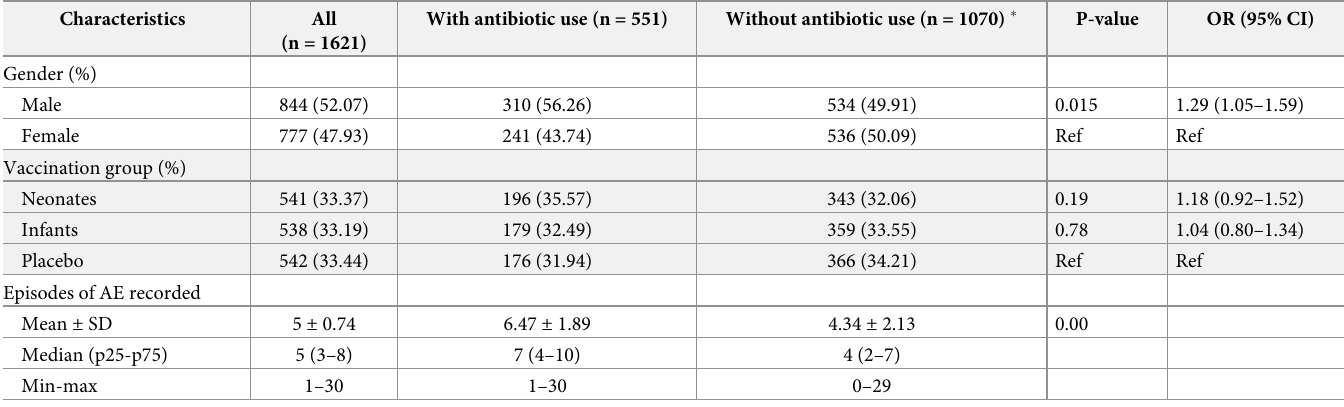
Table 1. Baseline characteristics of the study participants with antibiotic treatment. Characteristics